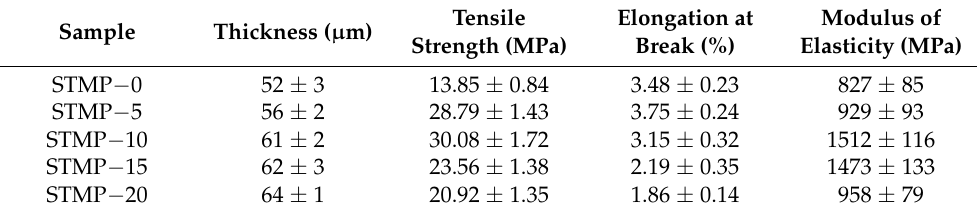
Table 2. Tensile test results of the STMP crosslinked hemicellulose